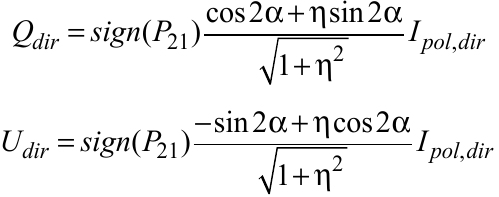
Figure 11. Similar to Figure 7, but with the modeled Q and U obtained from I